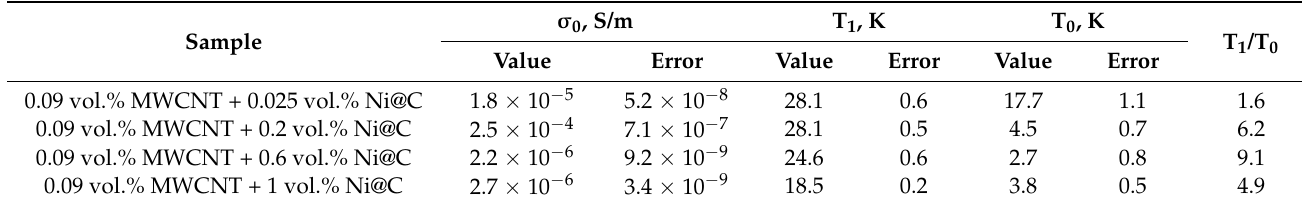
Table 3. Tunnelling model parameters for hybrid Ni@C/MWCNTs/epoxy composites.